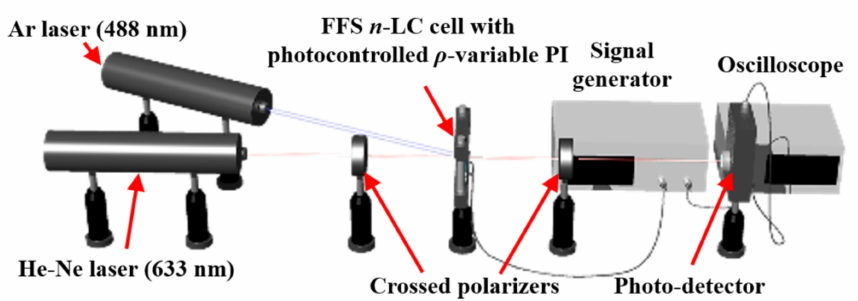
Figure 2. Experimental setup for characterizing the dynamics of voltage holding and discharging properties of the FFS n -LC mode used with the photocontrolled ρ -variable PI layer, where a He–Ne laser ( λ = 633 nm) is used as the probing beam for measuring the electro-optic properties of the LC cells and an Ar laser ( λ = 488 nm) is used as the excitation beam for photoinduced charge generation at the fullerene nanoparticles doped within the PI layer to control the PI resistivity